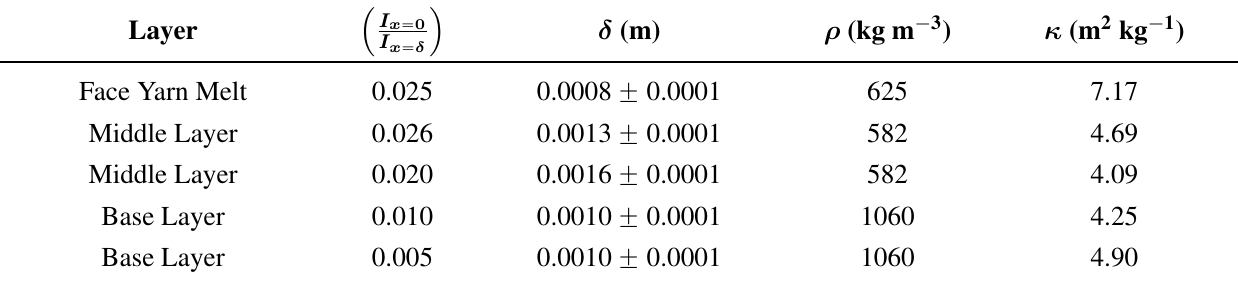
Table 4. Measurements used to calculate the absorption coefficient for each virgin and melt component.